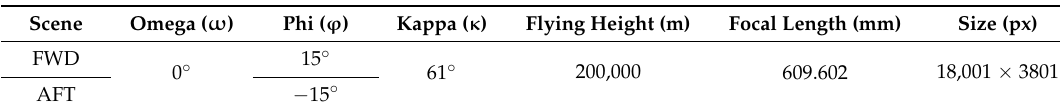
Table 3. Default scene parameter values. Ω , viewing angle across flight direction; φ , forward and backward camera tilt; κ , flight direction (0° = east).